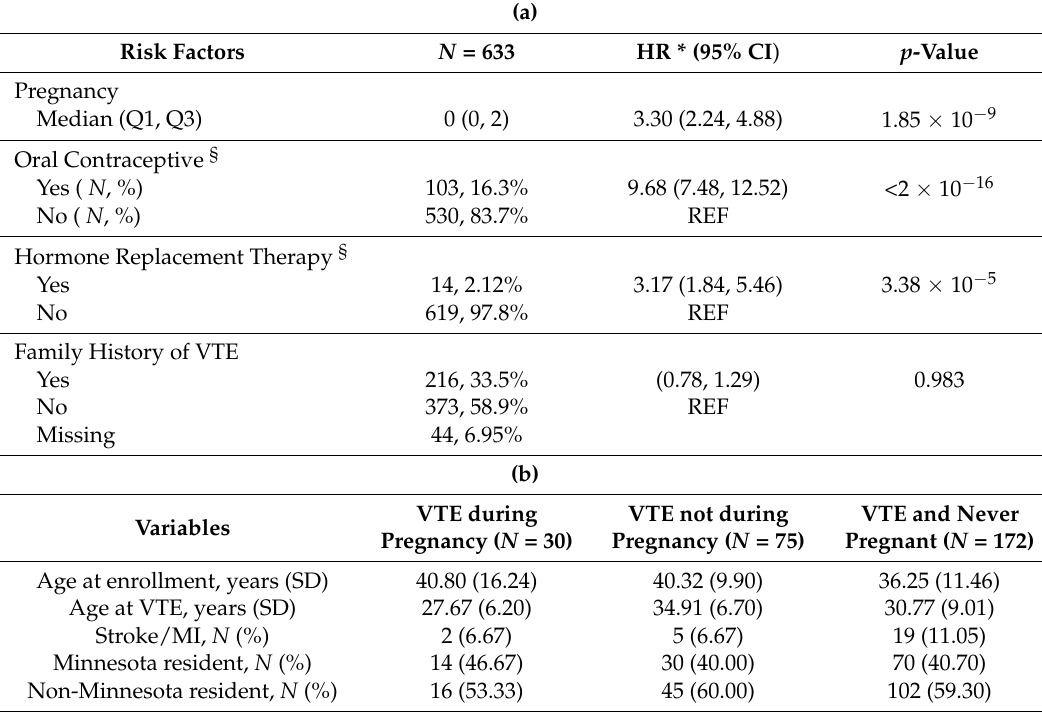
Table 1. ( a ) Distribution of main venous thromboembolism (VTE) risk factors in these 633 females; ( b ) Distribution of pregnancies between females, and within the pregnant women with VTE events, including age at enrollment in the study and age at VTE, stroke/myocardial infarction (MI), and state of